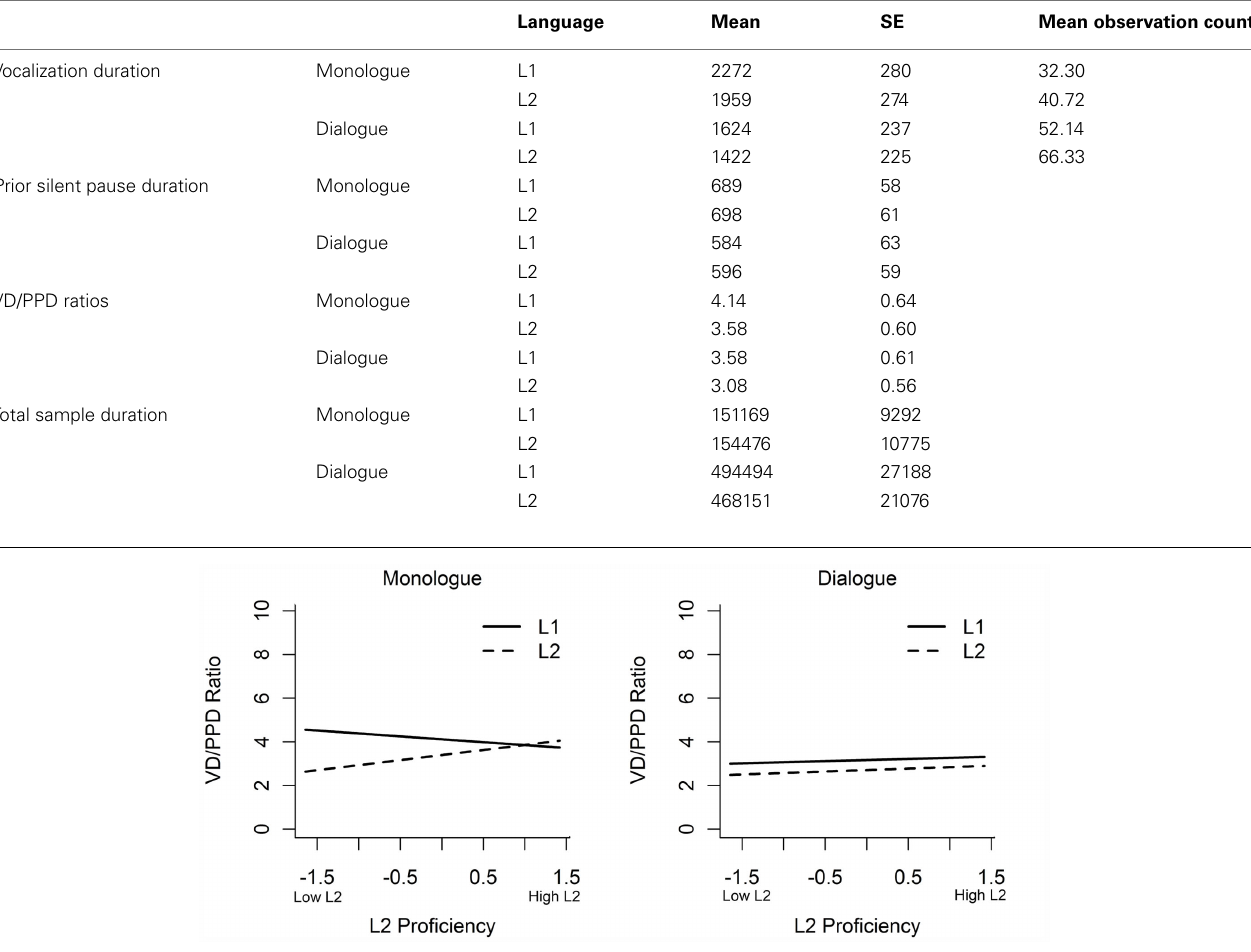
was lower in L2 vs. L1 for low L2 proficient bilinguals in monologues and across all L2 proficiency levels in dialogues. Speech planning and production was not different in L2 vs. L1 for high L2 proficient bilinguals in